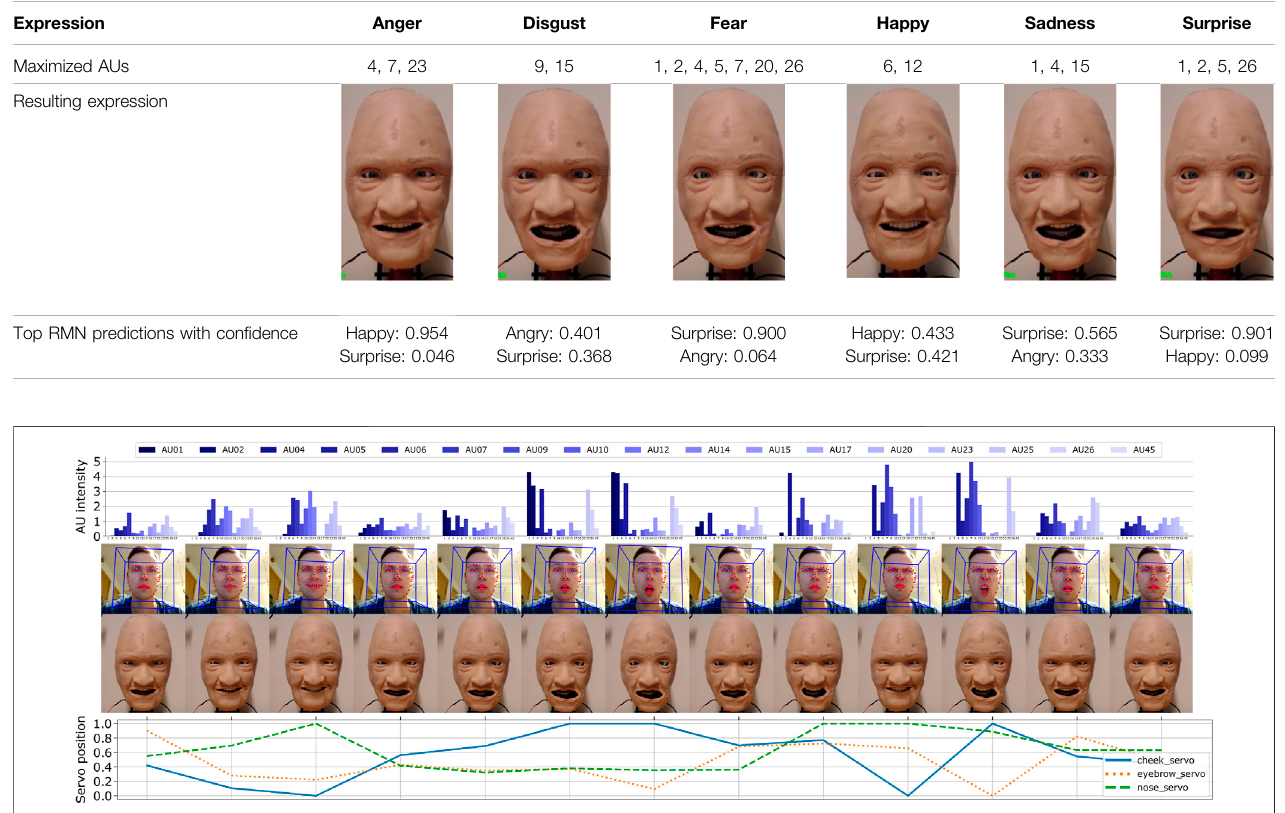
TABLE 3 | Generated face expressions with RMN predictions. Expression